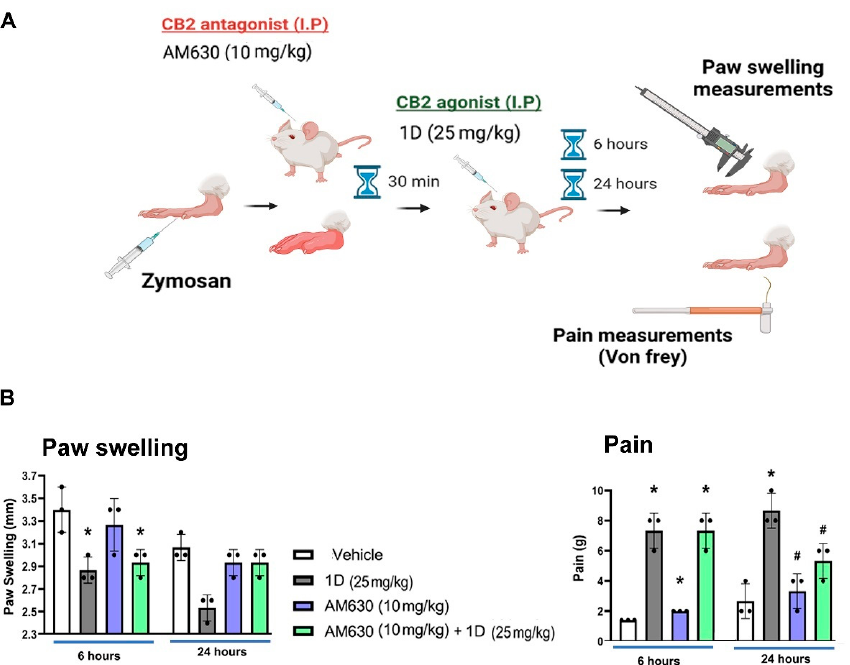
Figure 2. Assessment of 1D/1B effects in a mouse paw inflammatory pain model. Pain in mice was induced with zymosan and treated as detailed in materials and methods ( A ). ( B ) Graphs display paw swelling and pain (left and right graphs, respectively) of mice treated with 25 mg/kg (IP) 1D, and/or 10 mg/kg AM630. Statistical significance between treatments and vehicle control (denoted “*”) or between treatments and 1D control (denoted “#”), were examined via Kruskal–Wallis test with a Dunn’s post hoc analysis for scored (non-parametric) parameters, considering * p < 0.05 and # p < 0.05 to be statistically significant for both tests ( n = 3).